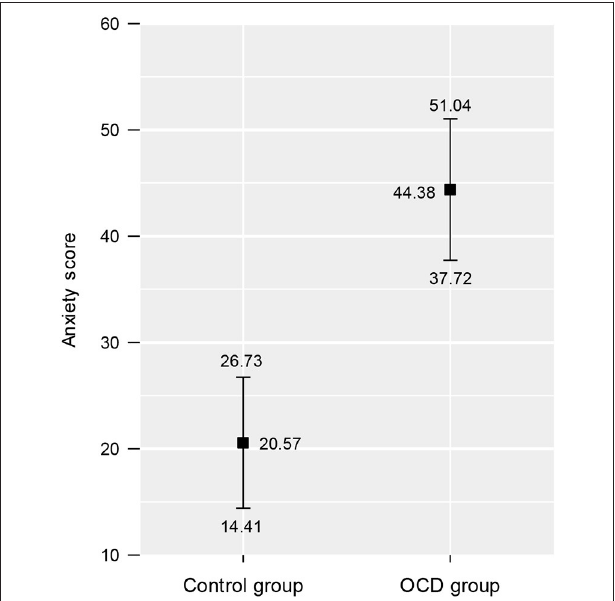
FIGURE 6 | Overall mean anxiety scores across the augmented reality stimuli for the control and clinical groups. The squares represent the 20% trimmed means, and the intervals show the standard errors of the 20% trimmed